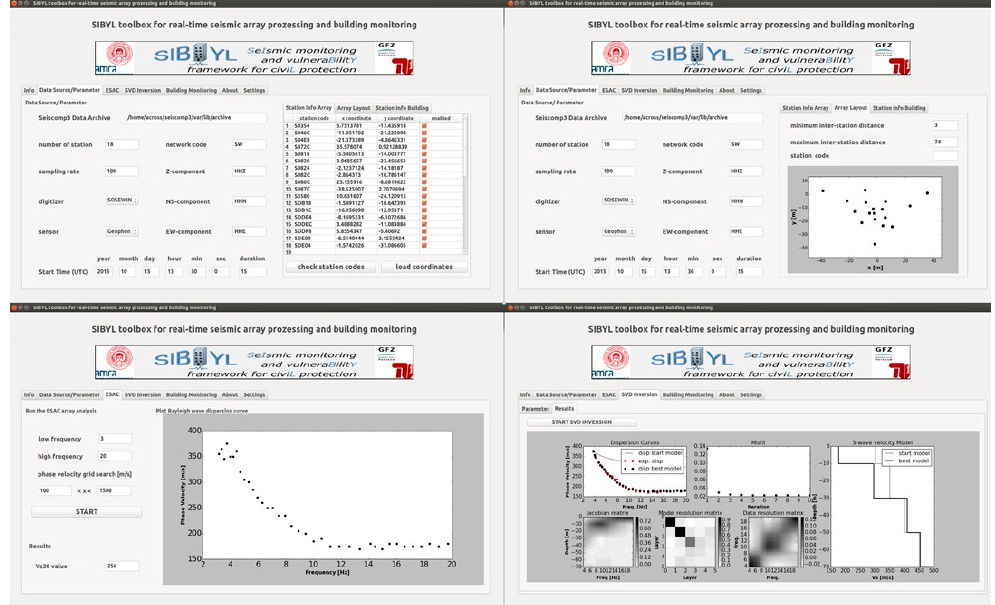
Figure 7. Output from the MPwise processing of seismic array data for site assessment (note, this is the Graphical User Interface (GUI) developed for the SIBYL project). Top left) The data source and parameter menu allows the user to configure different parameters, such as the number of stations, network code, sampling rate, channel identifier, digitizer and sensor specific constants, etc. Top right) Overview of the array geometry. Bottom left) Real-time processing of the array measurements using the extended spatial autocorrelation (ESAC) method [29] to obtain a Rayleigh wave dispersion curve. Bottom right) SVD (Single Value Decomposition) inversion to obtain a 1D shear wave velocity model, as well as a quality control provided by Jacobian, model and data resolution matrices.